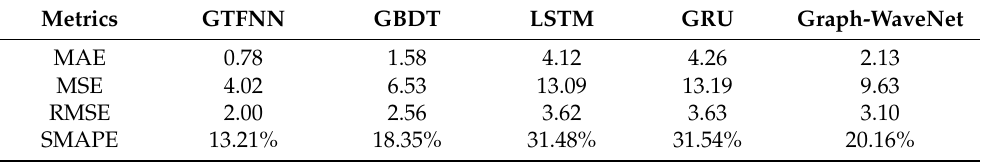
Table 7. The mean performances of models in forecasting weekends OD flow.